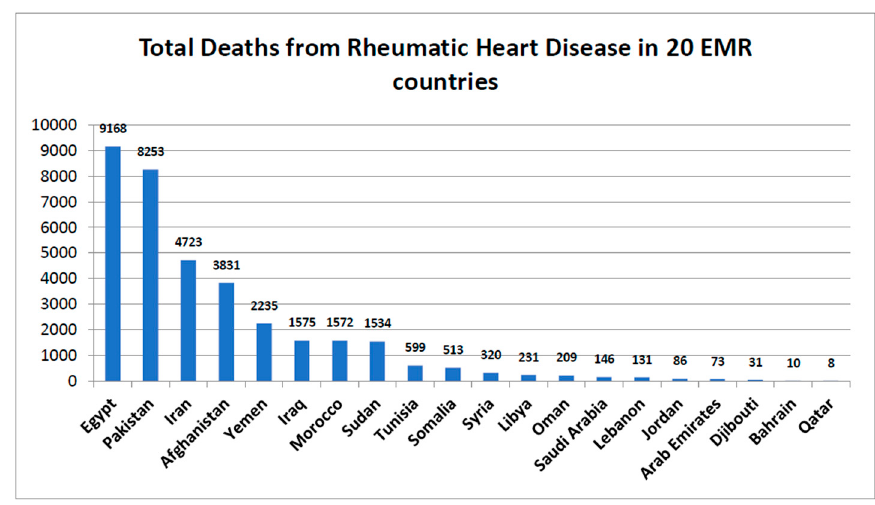
Figure 4. Total deaths from Rheumatic heart disease for the 20 countries with reported data in the Eastern Mediterranean region (Data source (www.worldlifeexpectancy.com), based on WHO data in 2014).